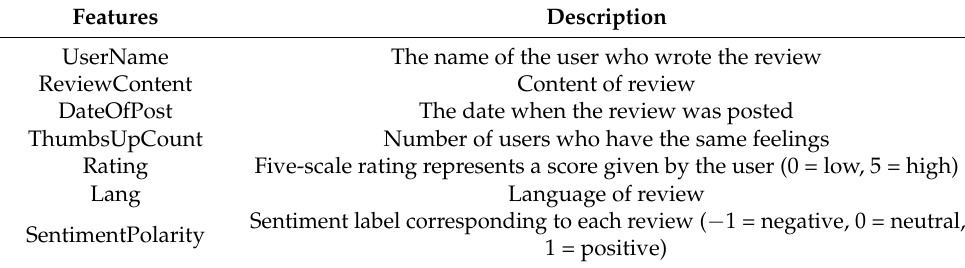
Table 4. Dataset